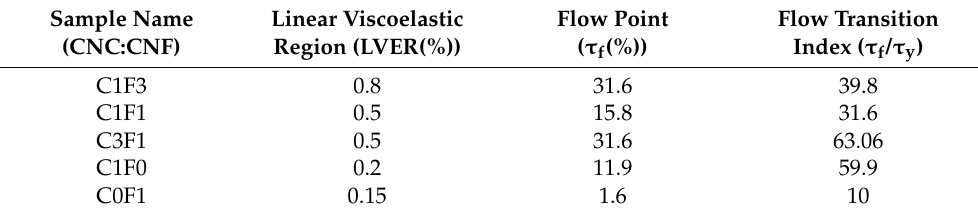
Table 3. Calculated linear viscoelastic region (LVER), flow point, and flow transition index of fabricated hydrogel